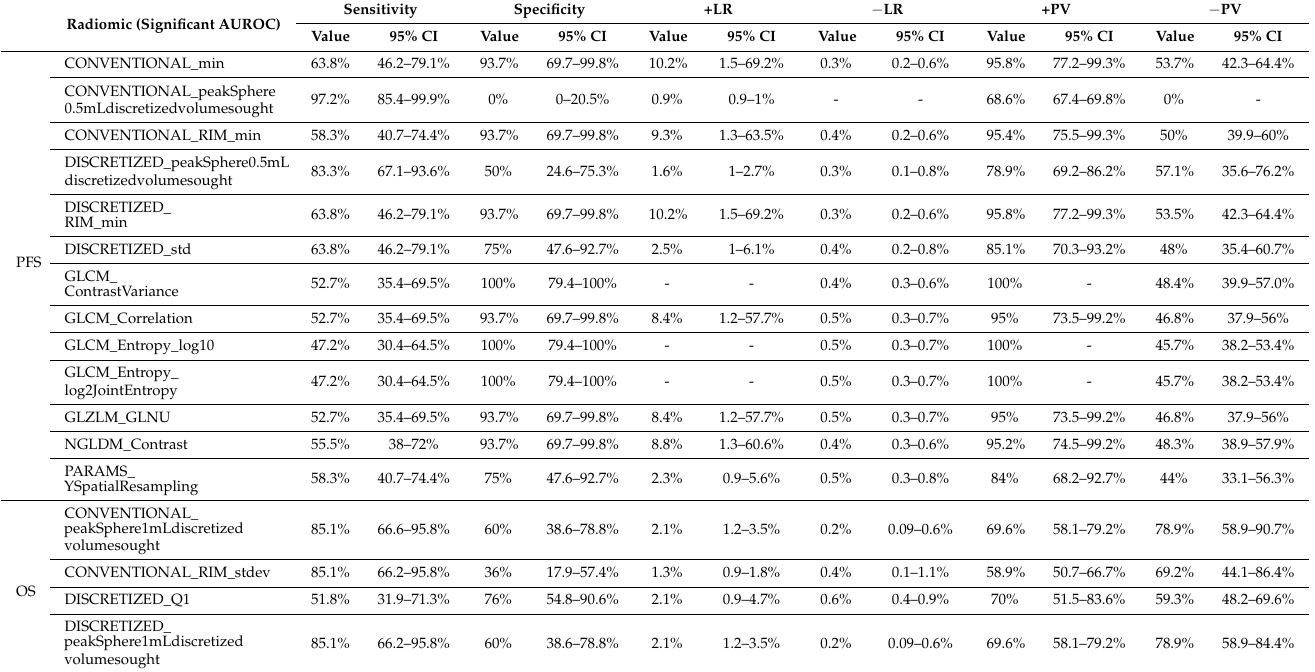
Table 3. Diagnostic performance test evaluation for the selected